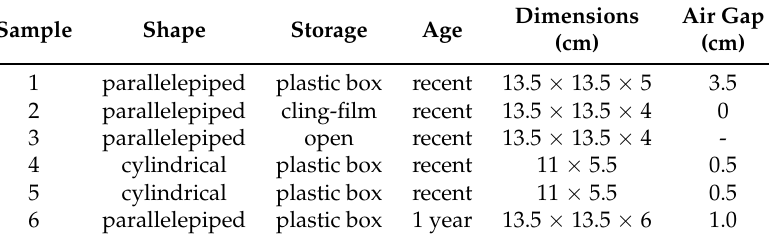
Figure 2. Photograph of the samples inside the containers. Table 2. Summary of the characteristics of the several